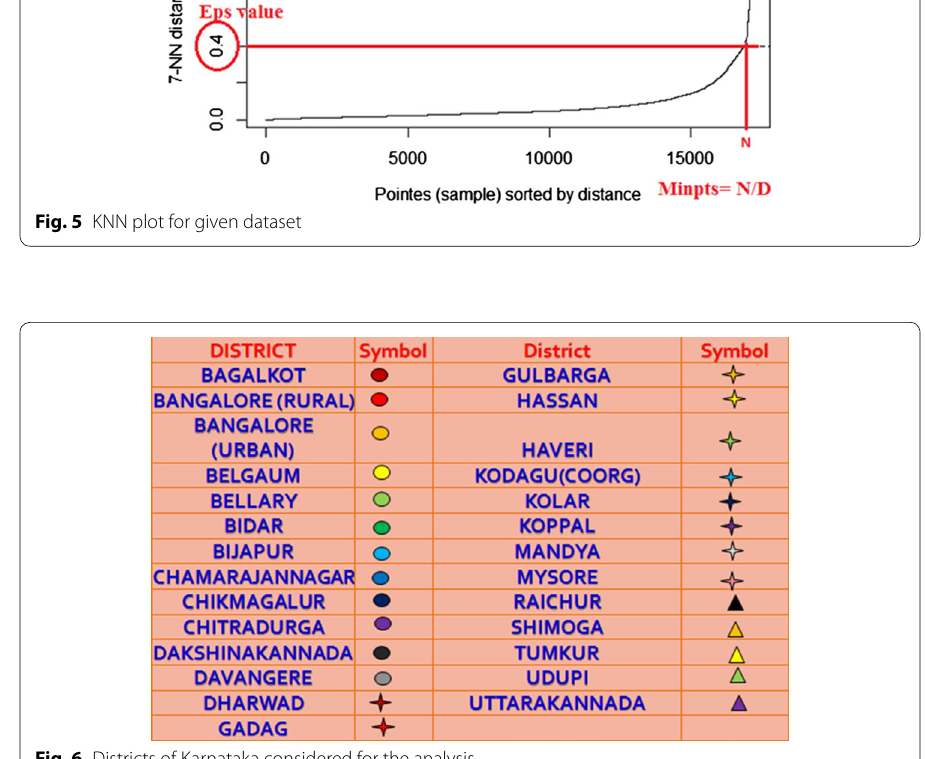
Fig. 6 Districts of Karnataka considered for the